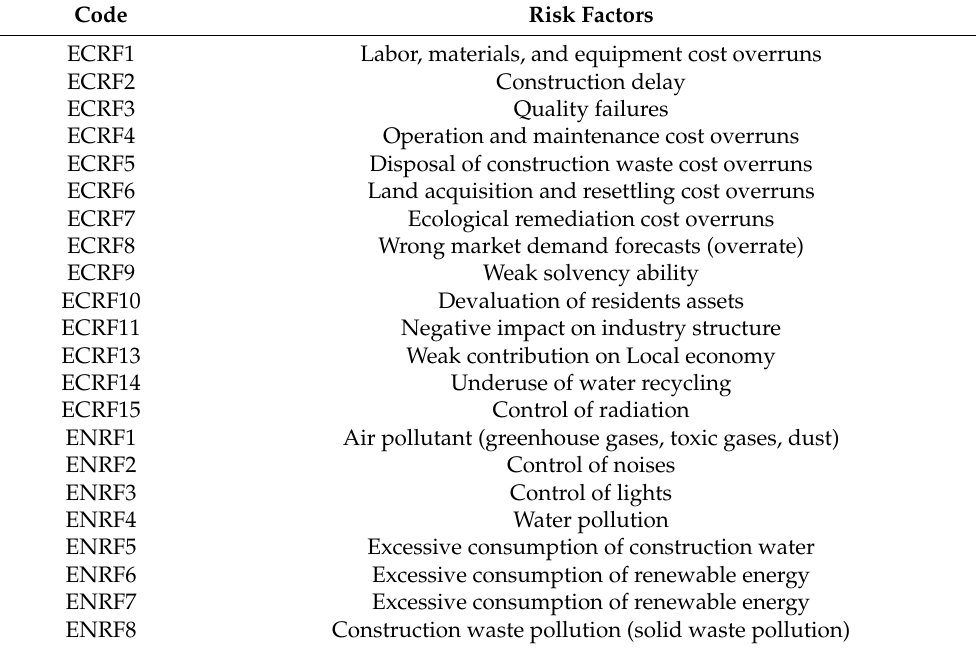
Table A1. Preliminary risk